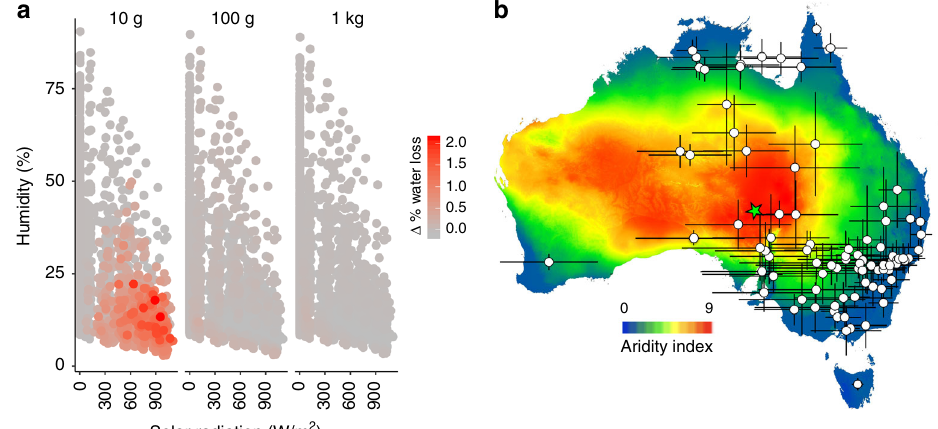
Fig. 3 Biophysical model results in Australia (Simpson Desert). a Estimated reductions in evaporative water loss due to high NIR (40% vs 10% re fl ectivity) under different combinations of solar radiation and humidity. Higher values (warmer colours) indicate a higher percentage of water saved by having higher plumage re fl ectivity; grey values (closer to zero) indicate no difference. Values estimated for three different sizes. b Aridity index values and mid- distribution points for the 90 species in our data set; bars contain ~50% of 1000 data points. The green star shows the location from which climate forcing data were obtained for the biophysical model. The map was extracted from the Atlas of Living Australia